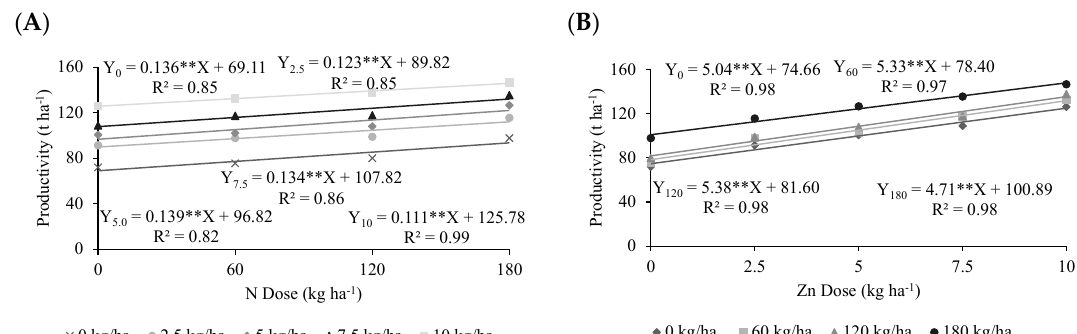
Figure 3. Sugarcane productivity (ratoon crops) in response to nitrogen ( A ) and zinc ( B ) fertigation doses under field conditions in Jataí, GO, Brazil. ** significant at p < 0,01 probability according to the F test. Doses of Zn, Y 0 : 0 kg ha − 1 of Zn, Y 2.5 : 2.5 kg ha − 1 of Zn, Y 5.0 : 5.0 kg ha − 1 of Zn, Y 7.5 : 7.5 kg ha − 1 of Zn and Y 10 : 10 kg ha − 1 of Zn ( A ). Doses of N, Y 0 : 0 kg ha − 1 of N, Y 60 : 60 kg ha − 1 of N, Y 120 : 120 kg ha − 1 of N, Y 180 : 180 kg ha − 1 of N ( B ).